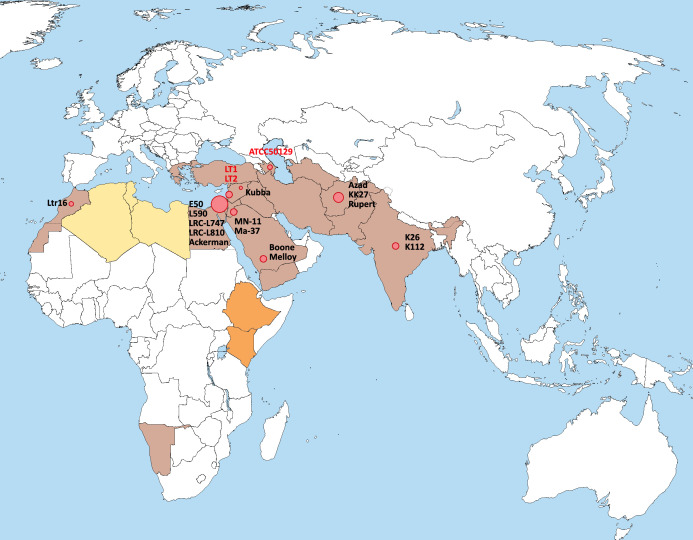
Map illustrating the geographic distribution of the analysed isolates of L. tropica and related lineages.The distribution of human CL caused by L. tropica, L. killicki and L. aethiopica, with the latter two considered to belong to the L. tropica complex [60] is shown as previously reported [2,7]. Brown: countries with CL caused by L. tropica (sensu stricto); yellow: countries with CL caused by both L. killicki and L. tropica; orange: countries with CL caused by both L. aethiopica and L. tropica. L. tropica isolates with genome sequence data analysed in this study are shown in red circles. The surface of the circles relates to the number of isolates derived from a given country. The three new genomes derived from this study are indicated in red letters (LT1, LT2 and ATCC50129).